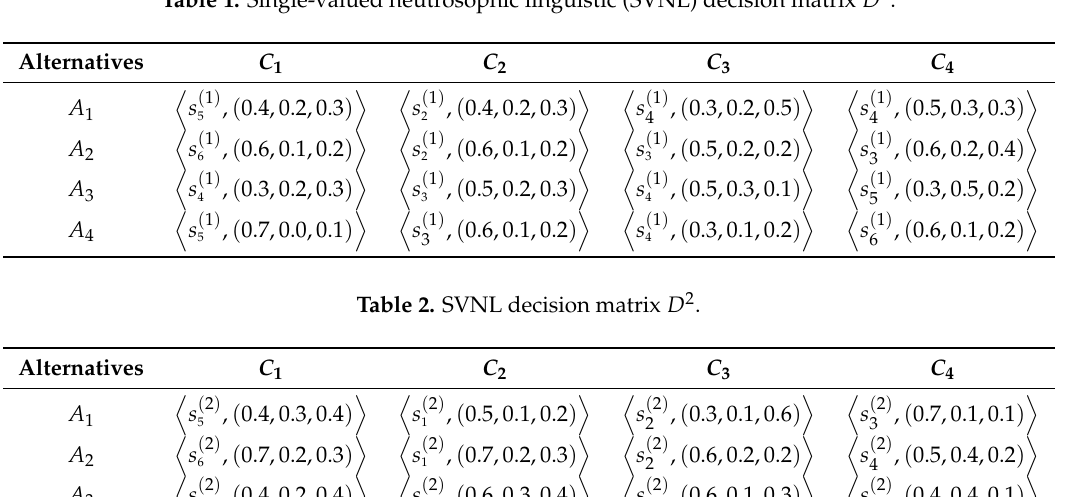
Table 1. Single-valued neutrosophic linguistic (SVNL) decision matrix D 1 .